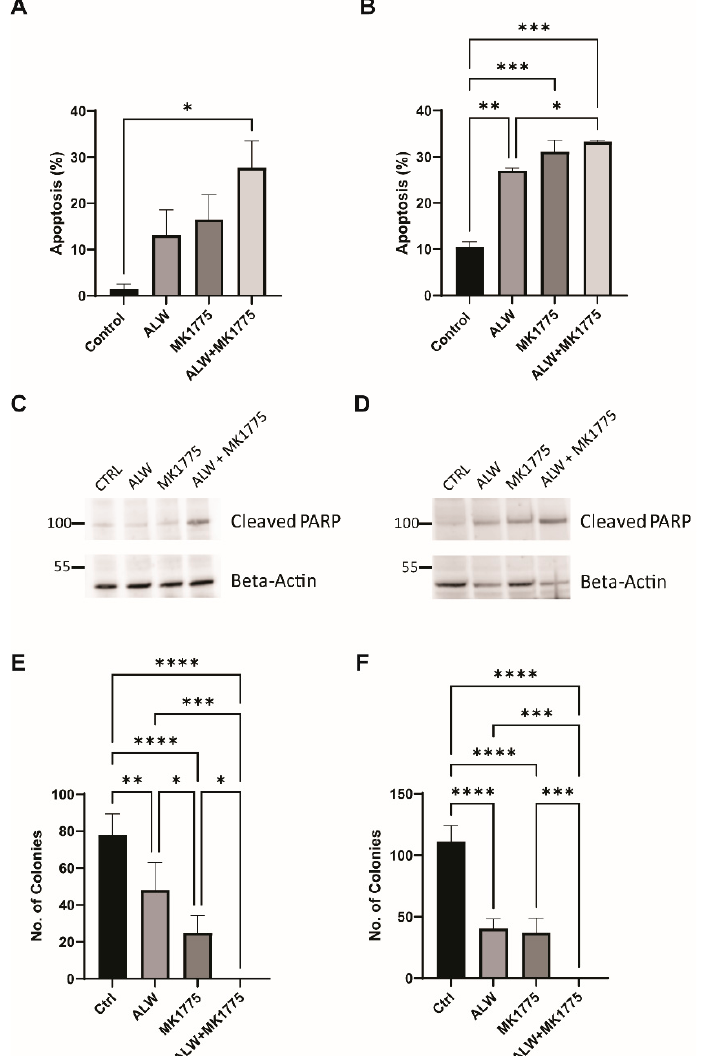
Figure 3. Apoptotic and clonogenic effects of combination therapy. ( A , B ) Flow cytometry analysis of apoptosis in Hec1A ( A ) and Ishikawa ( B ) cells that were untreated or treated with ALW, MK1775, or both drugs. ( C , D ) Expression of apoptosis marker cleaved PARP in untreated or drug-treated Hec1A ( C ) and Ishikawa ( D ) cells. ( E , F ) Clonogenic colony formation assay in untreated or drug-treated Hec1A ( E ) and Ishikawa ( F ) cells. Statistics were performed using one-way ANOVA with the Tukey’s post hoc test for multiple comparisons for more than two groups. ns, nonsignificant; * p < 0.05; ** p < 0.01; *** p < 0.001; **** p < 0.0001.